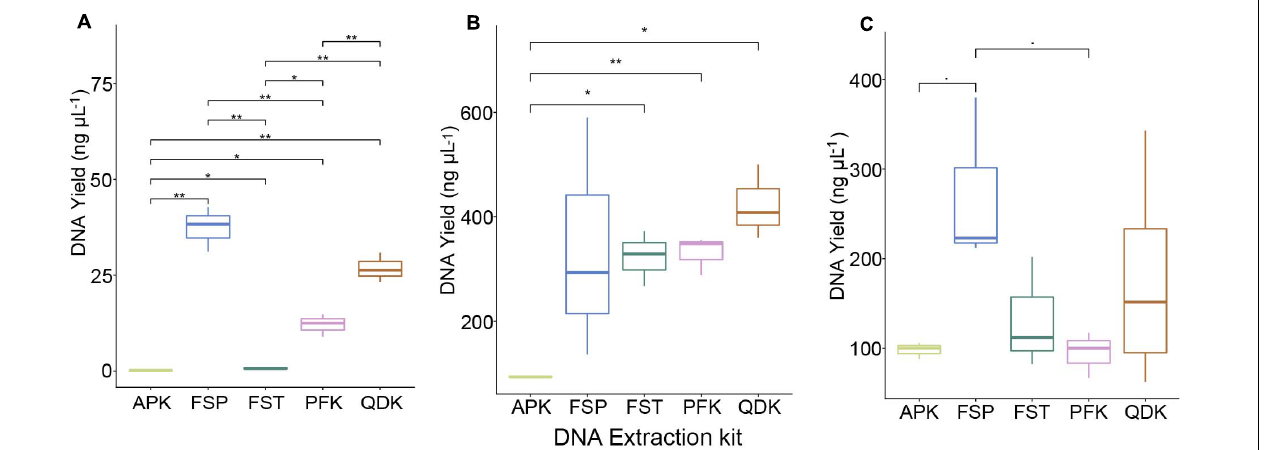
FIGURE 2 | DNA yield of DNA extractions from whole cells and intestinal material. DNA was extracted from a mock community and livestock samples using five commercial DNA extraction kits. Boxplots show the DNA yield (ng µ L − 1 ) after extracting the pure mock community (A) , pooled samples from chicken cecum (B) , and pig feces (C) . Values represent averages from triplicate DNA extractions. Significant differences were tested with the Kruskal–Wallis test, which were FDR corrected, with * P < 0.05, ** P < 0.01, and - P < 0.09.